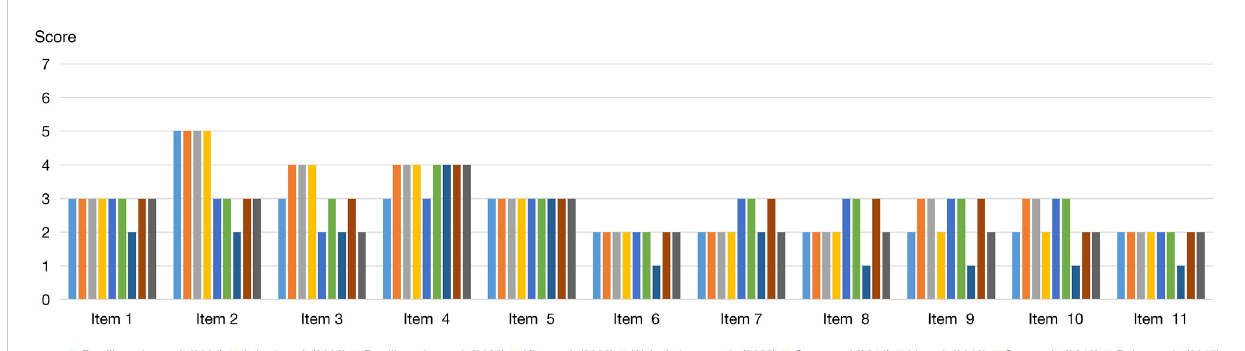
FIGURE 3 Methodological quality assessment using Q-genie tool (version 1.1), including 11 items: Item 1, rationale for study; Item 2, selection and de fi nition of outcome of interest; Item 3, selection and comparability of comparison groups; Item 4, technical classi fi cation of the exposure; Item 5, non-technical classi fi cationoftheexposure;Item6,othersourcesofbias;Item7,samplesizeandpower;Item8,aprioriplanningofanalyses;Item9,statisticalmethods and control for confounding;Item 10, testing of assumptions and inferences for genetic analyses; and Item 11, appropriateness of inferences drawn from